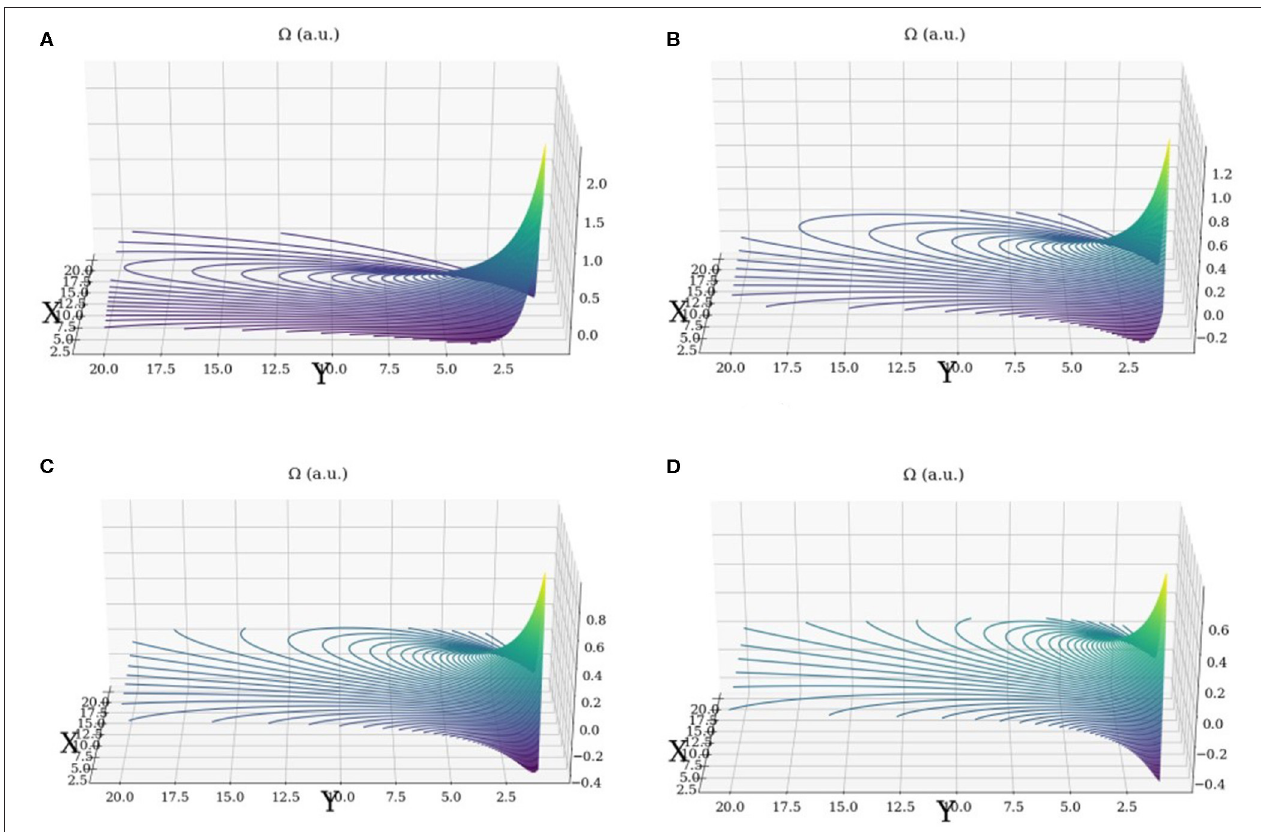
FIGURE 3 | Multifractal minimal vortex field (cid:127) , for θ